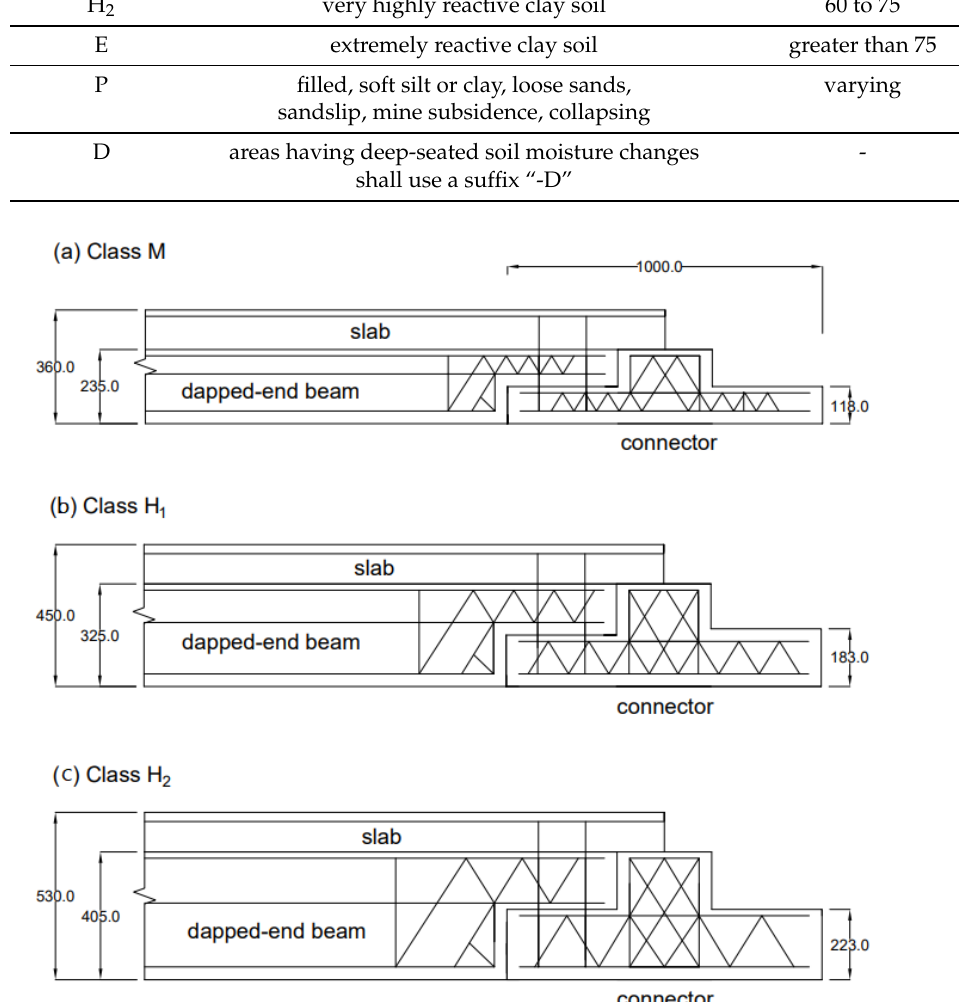
Figure 4. Section view of the developed prefabricated footing systems for ( a ) Class M/M-D, ( b ) Class H 1 /H 1 -D, and ( c ) Class H 2 /H 2 -D (length in